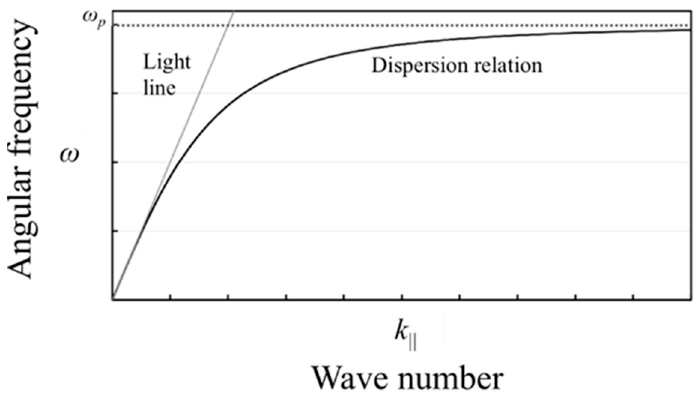
Figure 3. The dispersion relation of spoof surface plasmon polaritons ( SSPP) .